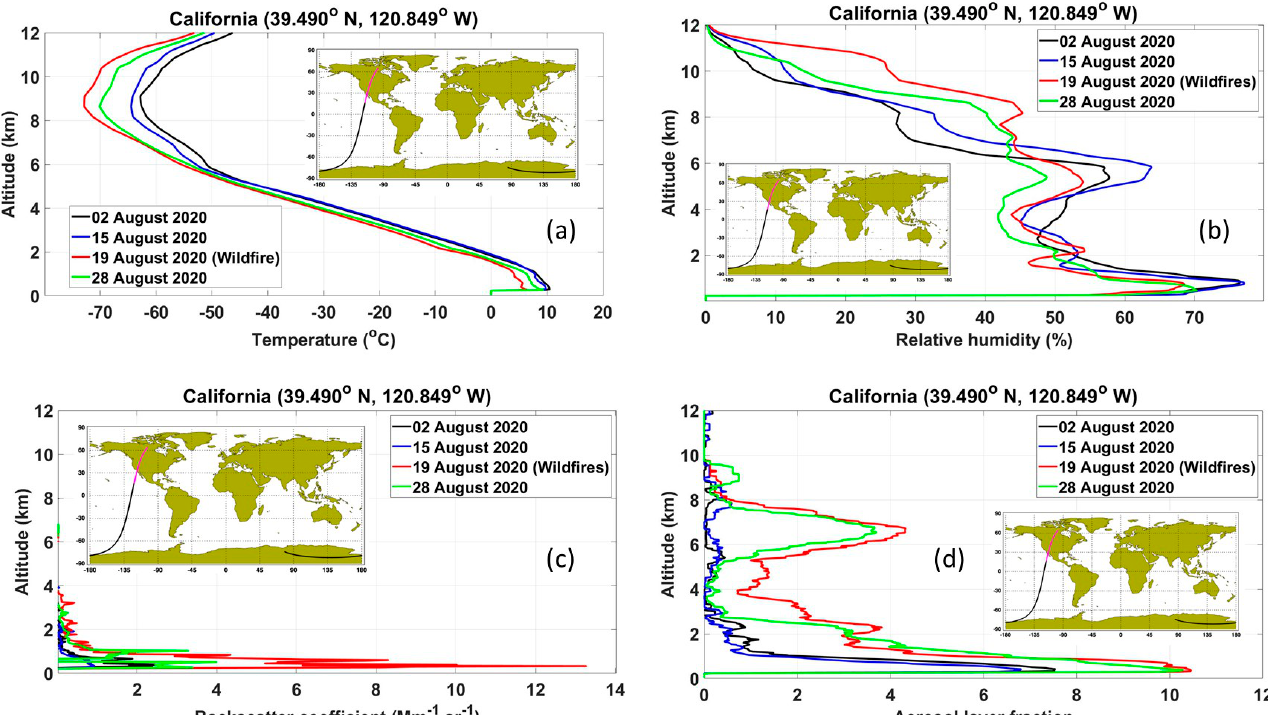
Figure 5. CALIOP vertical height profile over California for ( a ) temperature, ( b ) relative humidity, ( c ) backscatter coefficient and ( d ) aerosol layer fraction.